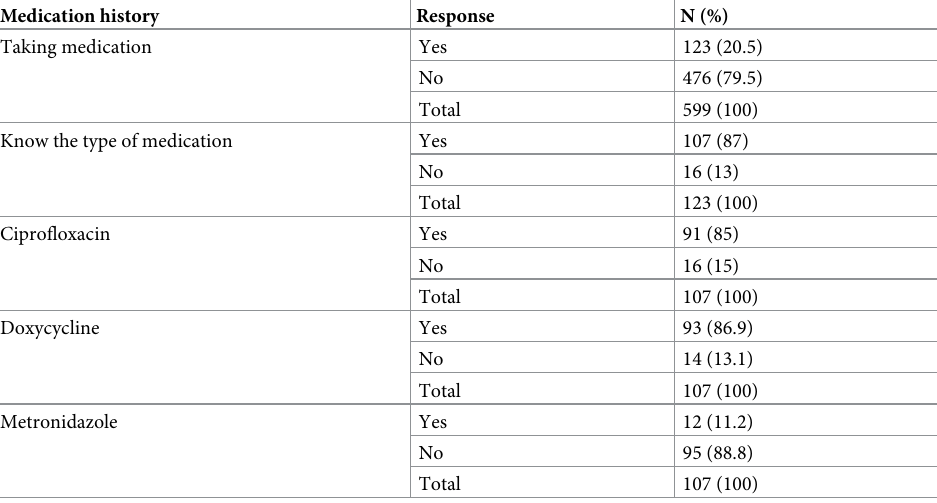
Table 3. Medical treatment history of patients with urethral discharge from health centers in Addis Ababa, August 2013–August